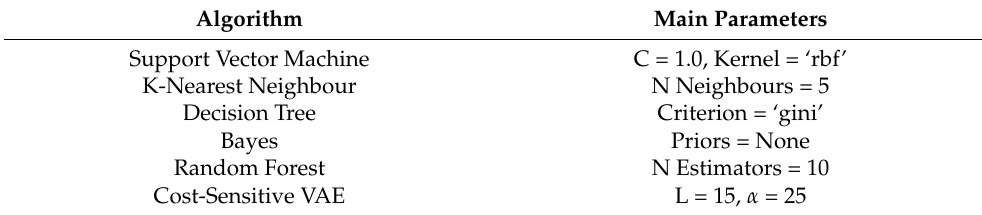
Table 2. Main parameters used in different learning algorithm.